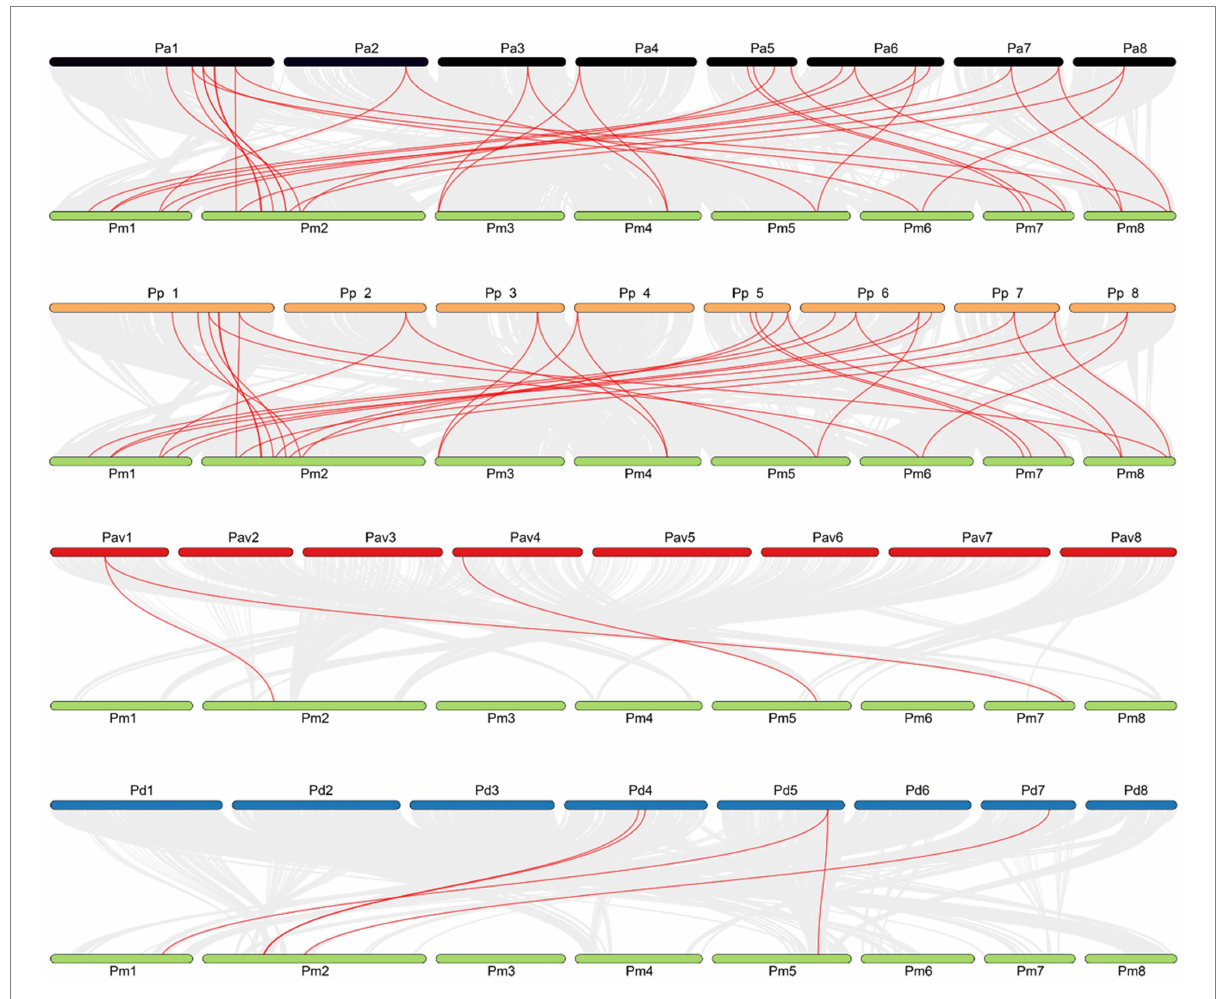
FIGURE 8 Collinear analysis of TALE gene family between Prunus mume and four kinds of Prunus species. The red lines represent gene pairs with a collinear relationship, grey lines represent other collinear gene pairs of non-TALE gene family members across genomes; Green represents P. mume chromosomes, black represents P. armeniaca chromosomes, orange represents P. persica chromosomes, red represents P. avium chromosomes, and blue represents P. dulcis